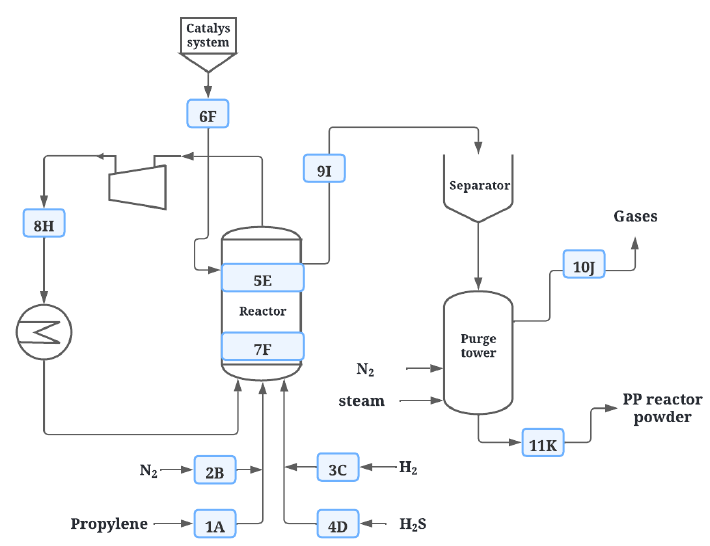
Figure 1. PP production scheme.